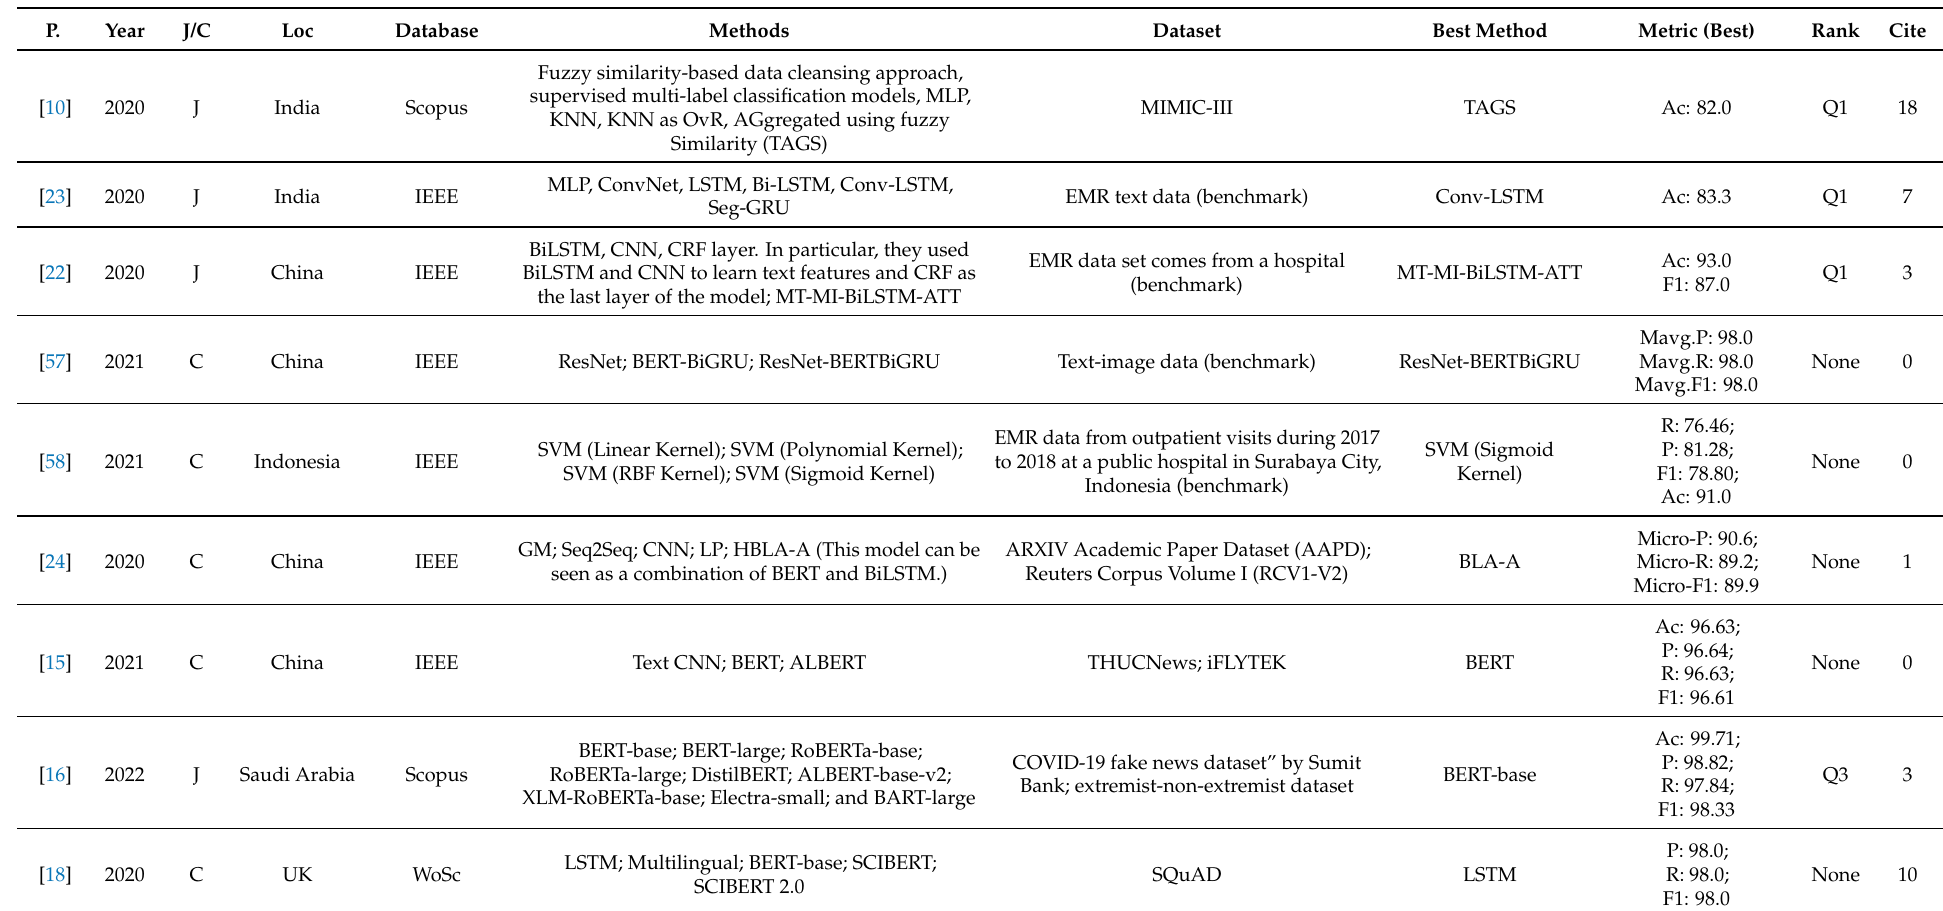
Table A1. Summary of papers filtering